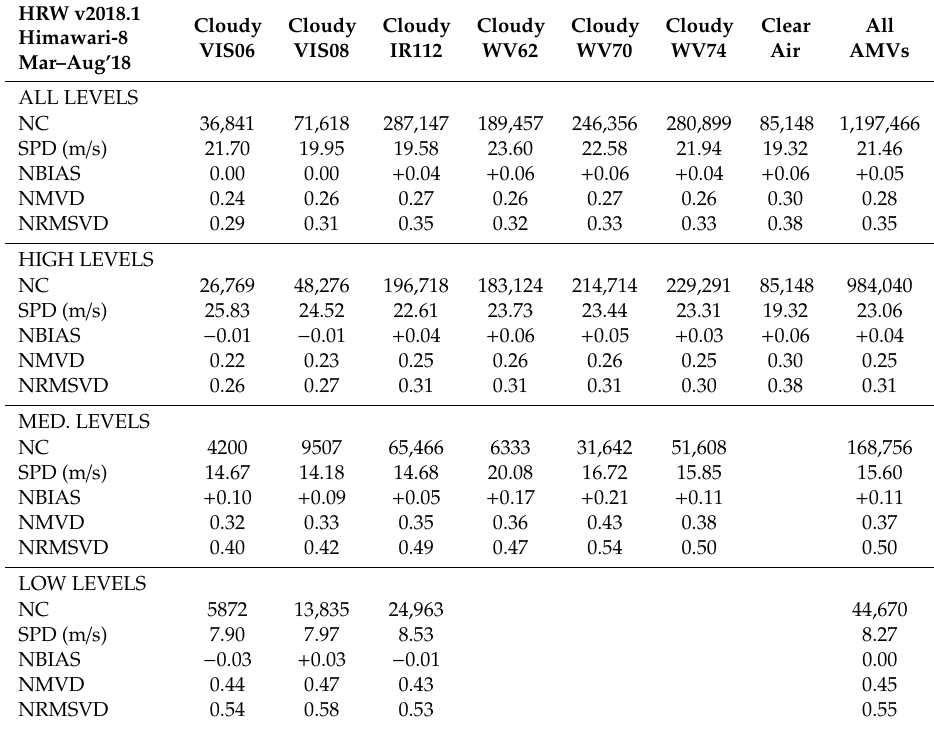
Table 5. Validation for NWC / GEO-HRW v2018.1 AMVs against radiosonde winds, considering all AMVs together and in three separate layers: high levels: 100–400 hPa; medium levels: 400–700 hPa; low levels: 700–1000 hPa (Mar 2018–Aug 2018, 00:00 UTC, Himawari-8 satellite, China / Korea / Japan region).